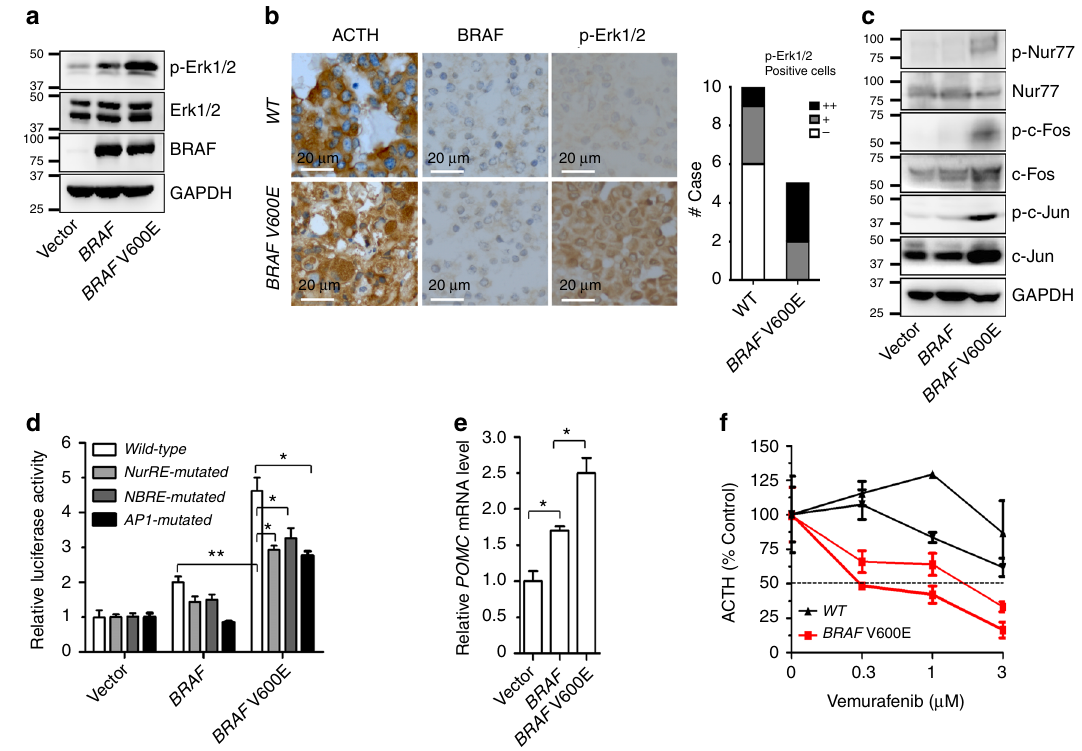
Fig. 2 BRAF V600E promotes POMC promoter activity and ACTH production. a Immunoblotting analysis of p-Erk1/2 and total Erk1/2 in AtT-20 stably infected with wild-type BRAF or BRAF V600E. b Immunohistochemical study of p-Erk1/2 in tumor samples according to the mutational status of BRAF . Scale bars, 20 μ m. P -value was calculated using two-tailed Fisher ’ s exact test ( P = 0.036). c Immunoblotting analysis of indicated proteins in AtT-20 cells as described in a . d Activities of wild-type or various mutated POMC promoters in cells transfected with wild-type BRAF or BRAF V600E together with a control vector expressing renilla luciferase. Y -axis: ratio of luciferase activity/renilla activity, presented as the means of three experiments and expressed relative to empty control vector. Error bars represent SEM of three measurements. e Relative mRNA levels of POMC in AtT-20 cells stably infected with indicated constructs. Data are expressed relative to the empty control vector after normalization to Hprt. Error bars represent standard SEM of three measurements. * P < 0.05, ** P < 0.01, two-tailed Student ’ s t -test ( d, e ). f The inhibitory effect of vemurafenib on ACTH production in primary cultured human corticotroph adenomas (two wild-type and two BRAF V600E). ACTH levels in culture media were measured by radioimmunoassay and presented as % of the control media. Error bars indicate SEM of three replicates. The dashed line represents IC